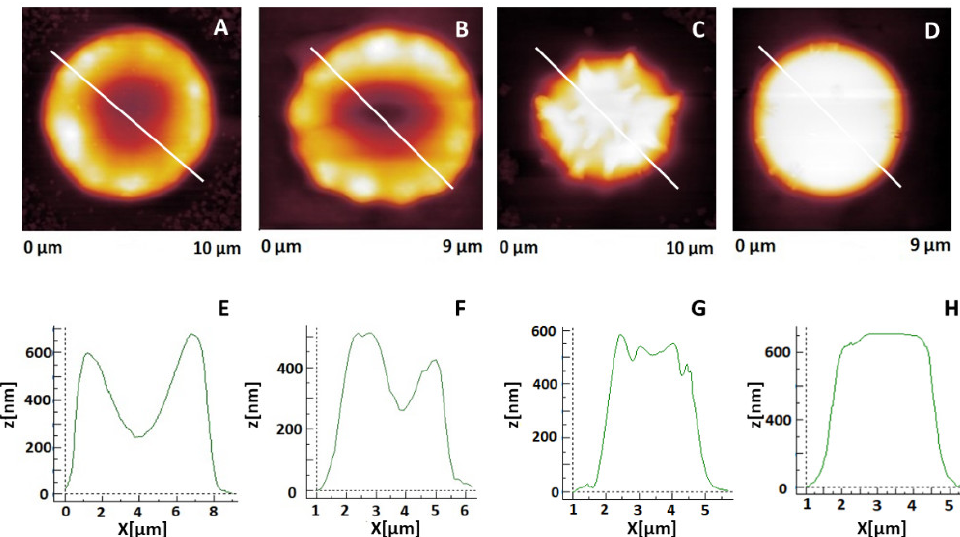
Figure 1. Typical AFM (2D) images of the four morphological classes of erythrocytes during cells’ aging: ( A ) biconcave disk; ( B ) crenated; ( C ) spiculated, and ( D ) spherocytes. The corresponding cross-sectional profiles of the cells defined by the white line of the AFM images from panels ( A – D ) are presented in panels ( E – H ), respectively.